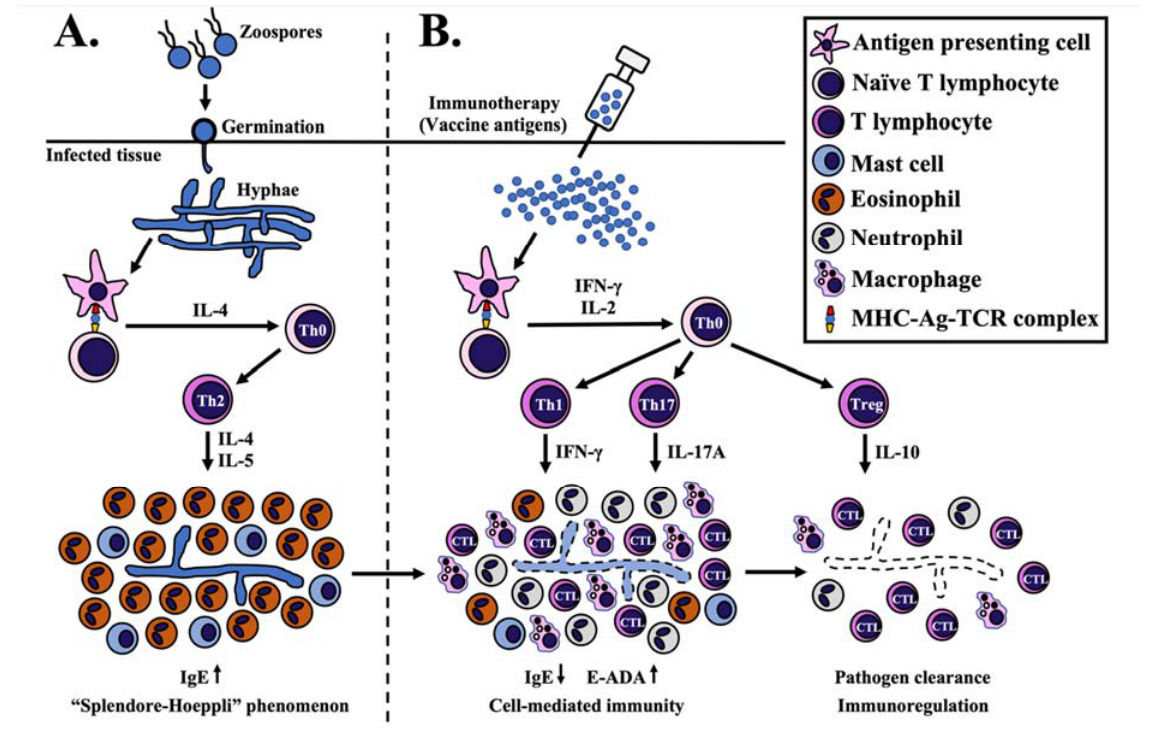
Figure 1. Proposed mechanism of P. insidiosum antigen (PIA) immunotherapy. ( A ) P. insidiosum ’s zoospores (asexual stage) attach and germinate as hyphae into the host tissue during natural infection. Antigen-presenting cells (APC) process and present the P. insidiosum antigens to naïve T lymphocytes via major histocompatibility complex-antigen-T cell receptor complex (MHC-Ag-TCR). This interaction elevates some cytokines (mainly IL-4) to differentiate and clonally proliferate a naïve CD4+ T (Th0) to T helper-2 (Th2) cell, which, in turn, produces IL-4 and IL-5 to attract and activate eosinophils and mast cells. The eosinophils surround the P. insidiosum , creating the histological phenomenon called “Splendore-Hoeppli”. ( B ) Processed antigens (prepared from the crude extract of P. insidiosum ) lead to forming the MHC-Ag-TCR complex that induces the release of some cytokines, mainly IFN- ϒ and IL-2. IFN- ϒ promotes differentiation and clonal proliferation of a Th0 to T helper-1 (Th1) cell. Th1 cell-produced IFN- ϒ attracts macrophages and cytotoxic T lymphocytes (CTL) to the infection site for eliminating the pathogen. The MHC-Ag-TCR complex also facilitates the differentiation of a Th0 to T helper 17 (Th17) cell to produce IL-17A and accumulate more macrophages and neutrophils at the infection area. On the other hand, IL-2 promotes the differentiation of a Th0 to regulatory T (Treg) cell to regulate or suppress an excessive immune response through the release of IL-10. See the text for the details and the references to the proposed mechanism of PIA immunotherapy.